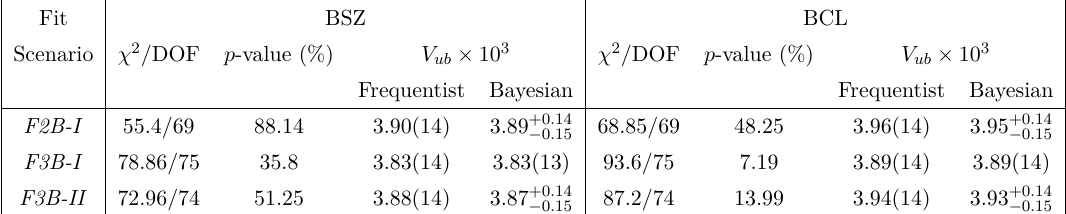
Table 11 . Final table of comparison for | V ub | exc . obtained in this work.